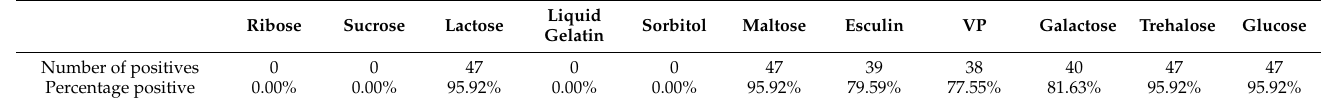
Table 3. Biochemical results of 49 L. garvieae isolates.